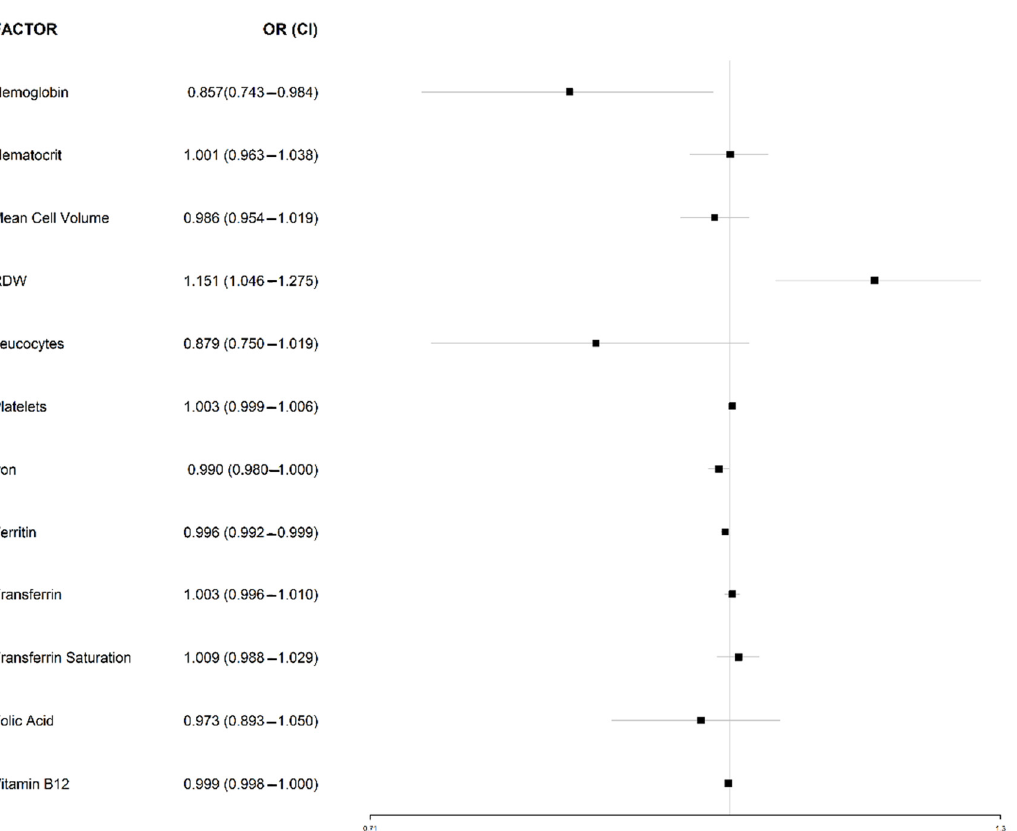
Figure 3. Association between hematological parameters and CD. Logistic regression for comparison of patients newly diagnosed with CD and without CD. Odds ratio with 95% confidence interval. Abbreviations: CI, Coefficient interval; Hct, Hematocrit; MCV, Mean Cell Volume; OR, Odd ratio;